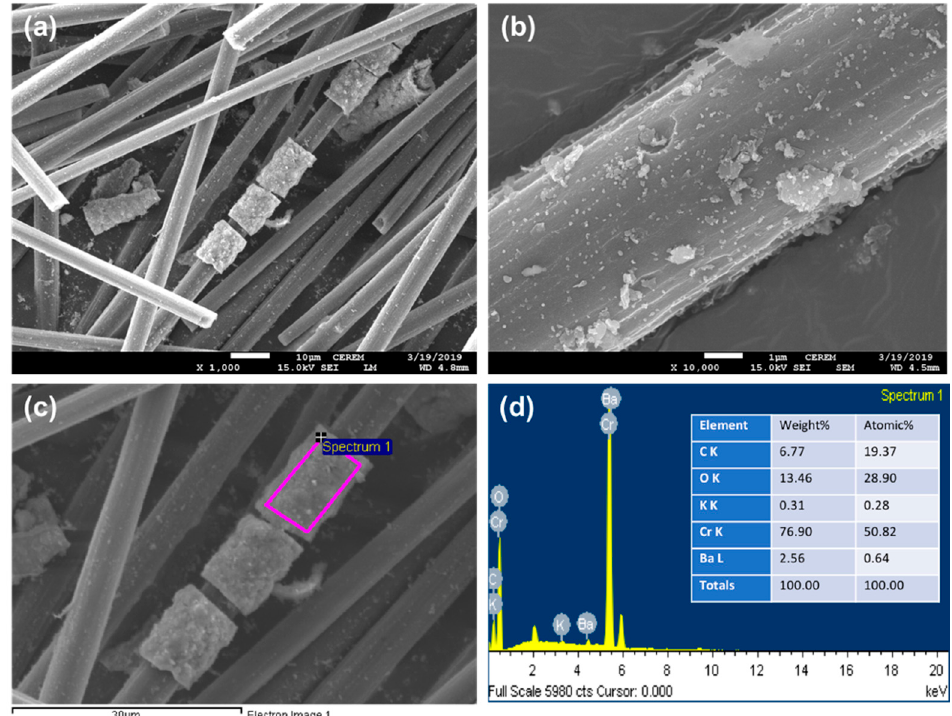
Figure 5. Heat-treated carbon fibers at 450 °C: ( a ) SEM image at low resolution; ( b ) SEM image at high resolution; ( c ) Selected area for EDAX analysis; and ( d ) EDAX elemental analysis.